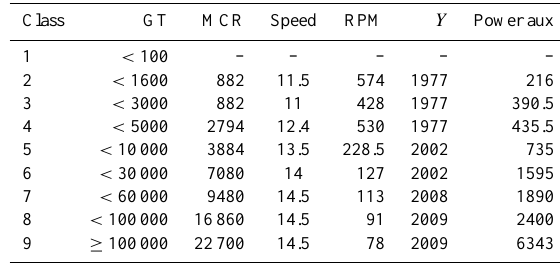
Table A2. Class medians for bulk carriers.